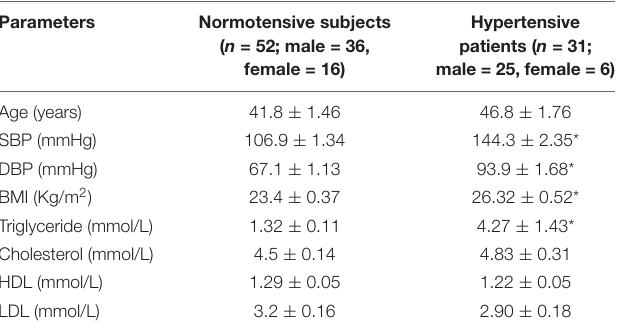
TABLE 2 | Clinical characteristics of the human subjects.